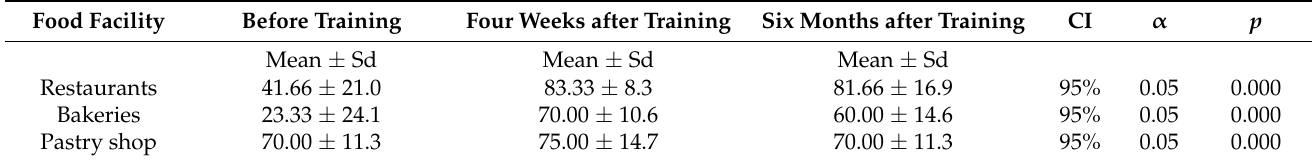
Table 8. Differences in results of swabs analysis in all three types of food facilities.